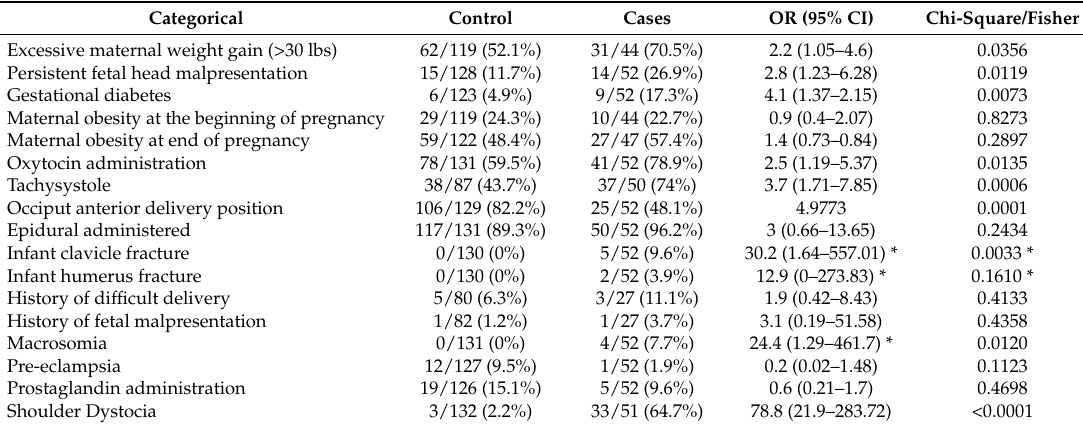
Table 2. Comparison results between risk factors for brachial plexus birth injury (BPBI) controls and